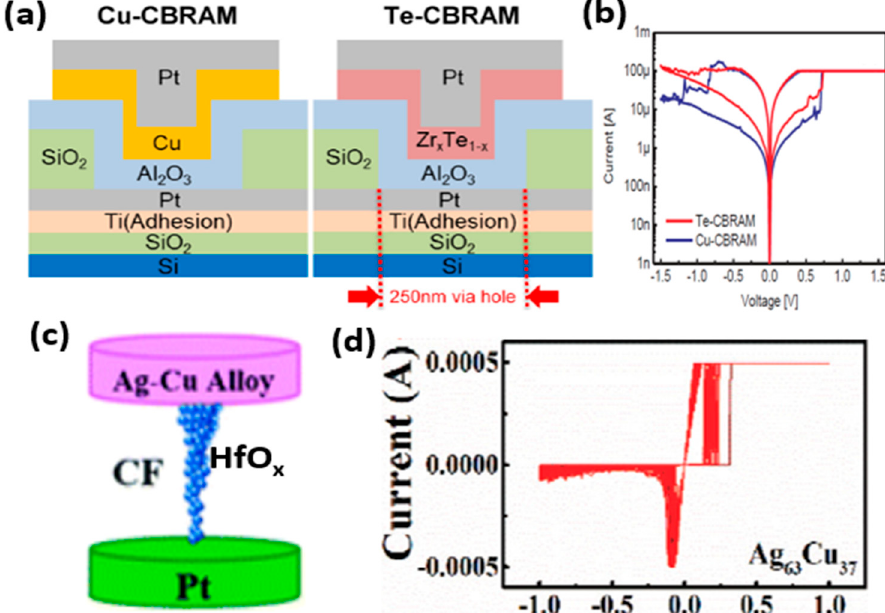
Figure 3. The CBRAM devices with different AE materials. ( a ) The schematic diagrams of the Cu- CBRAM and Te-CBRAM devices. ( b ) The basic I–V characteristics of the Cu-CBRAM and Te-CBRAM devices. Reprinted from Ref. [19]. ( c ) The schematic diagram of the CBRAM device with Ag-Cu alloy-based AE. ( d ) The I–V characteristics of the Ag–Cu alloy-based CBRAM device with an Ag-Cu ratio of 63:37. Reprinted from Ref. [40].